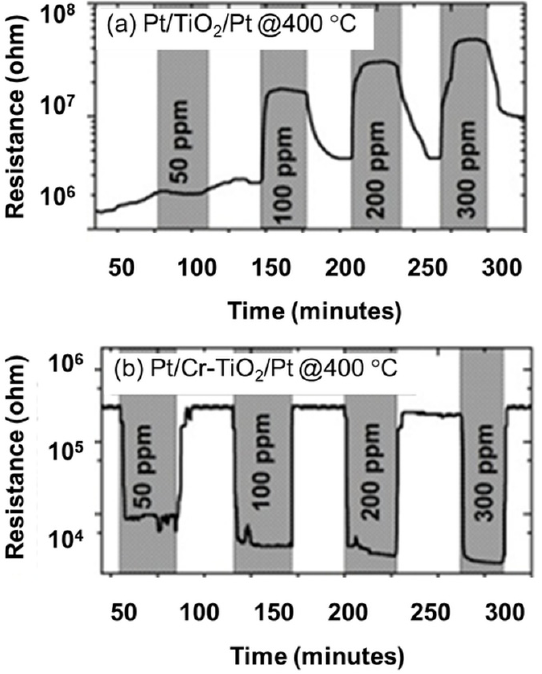
Figure 6. The dynamic responses of Pt/TiO 2 /Pt and Pt/Cr-TiO 2 /Pt sensors measured at 400 ◦ C toward different concentrations (50, 100, 200, 300 ppm) of NO 2 gas.